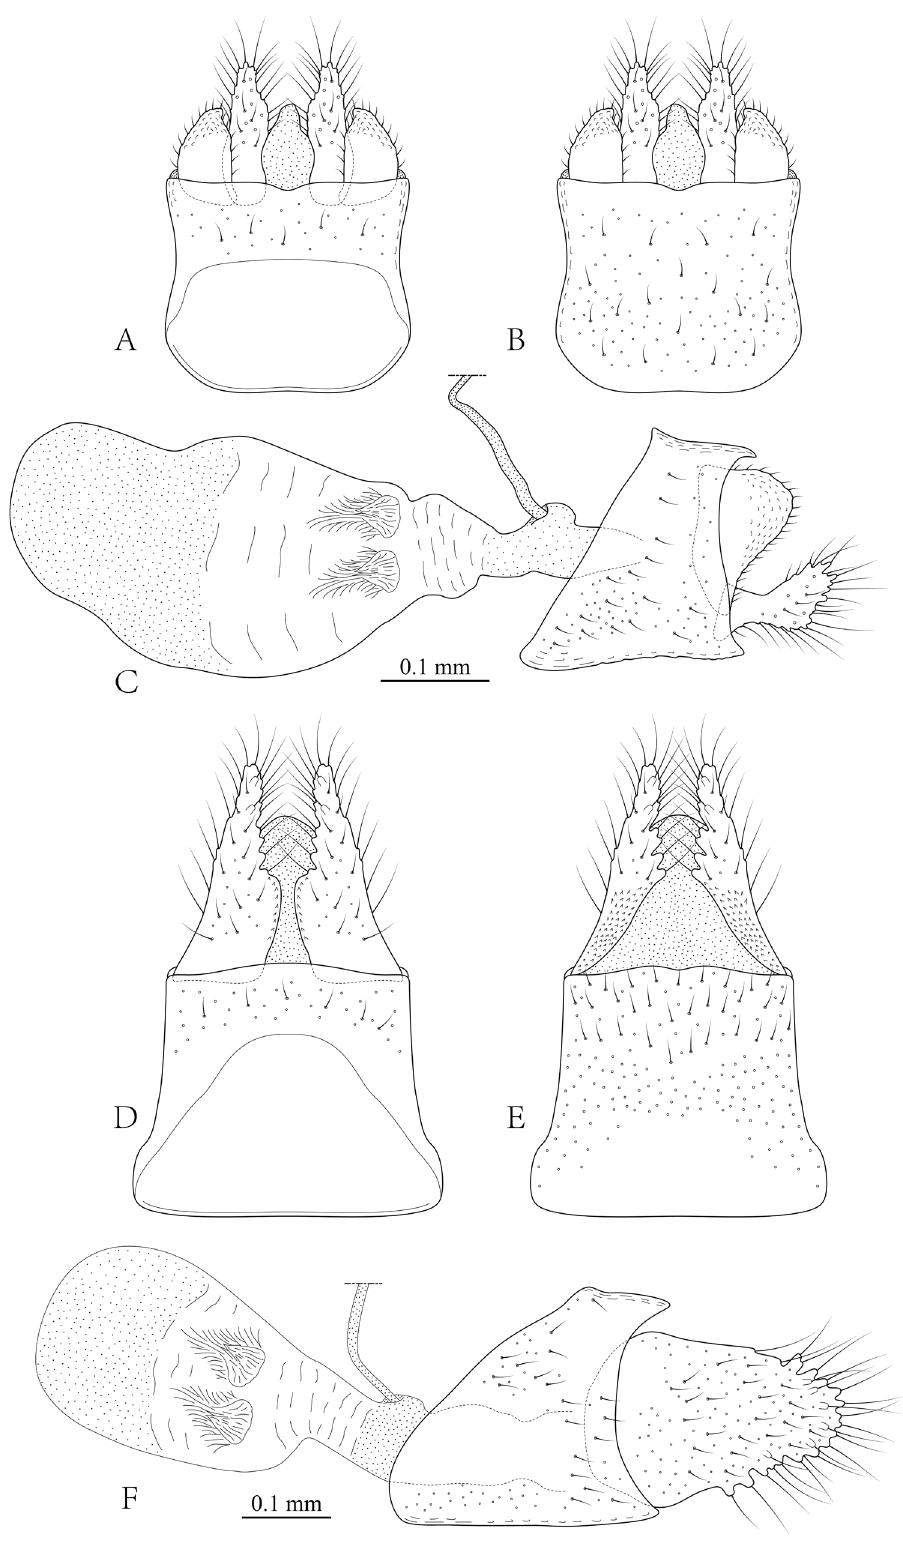
Fig. 5. Female genitalia of Vietomartyria spp. A–C . Vietomartyria wuyunjiena sp. nov. D–F . V. maoershana sp. nov. A, D . Terminalia, dorsal view. B, E . Ditto , ventral view. C, F . Terminalia and bursa copulatrix, lateral